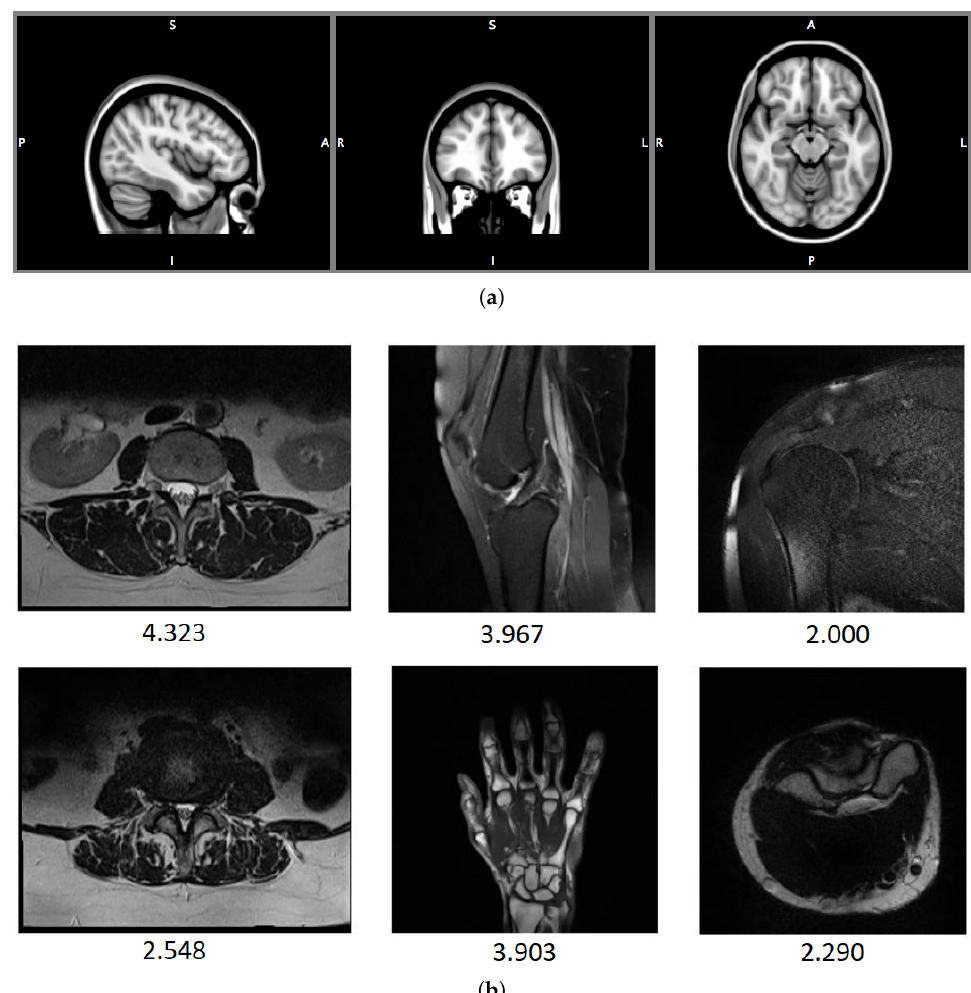
Figure 2. Exemplary MR images from OpenfMRI ( a ) and DB1 ( b ) databases. MOS values for images from DB1 database are also